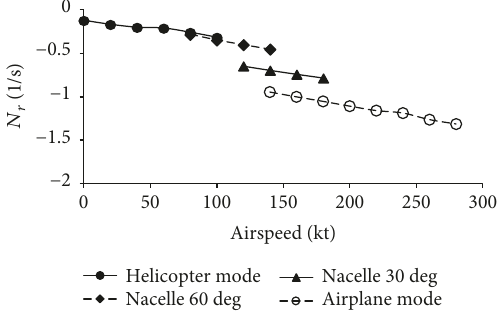
Figure 15: Variation of the derivative N